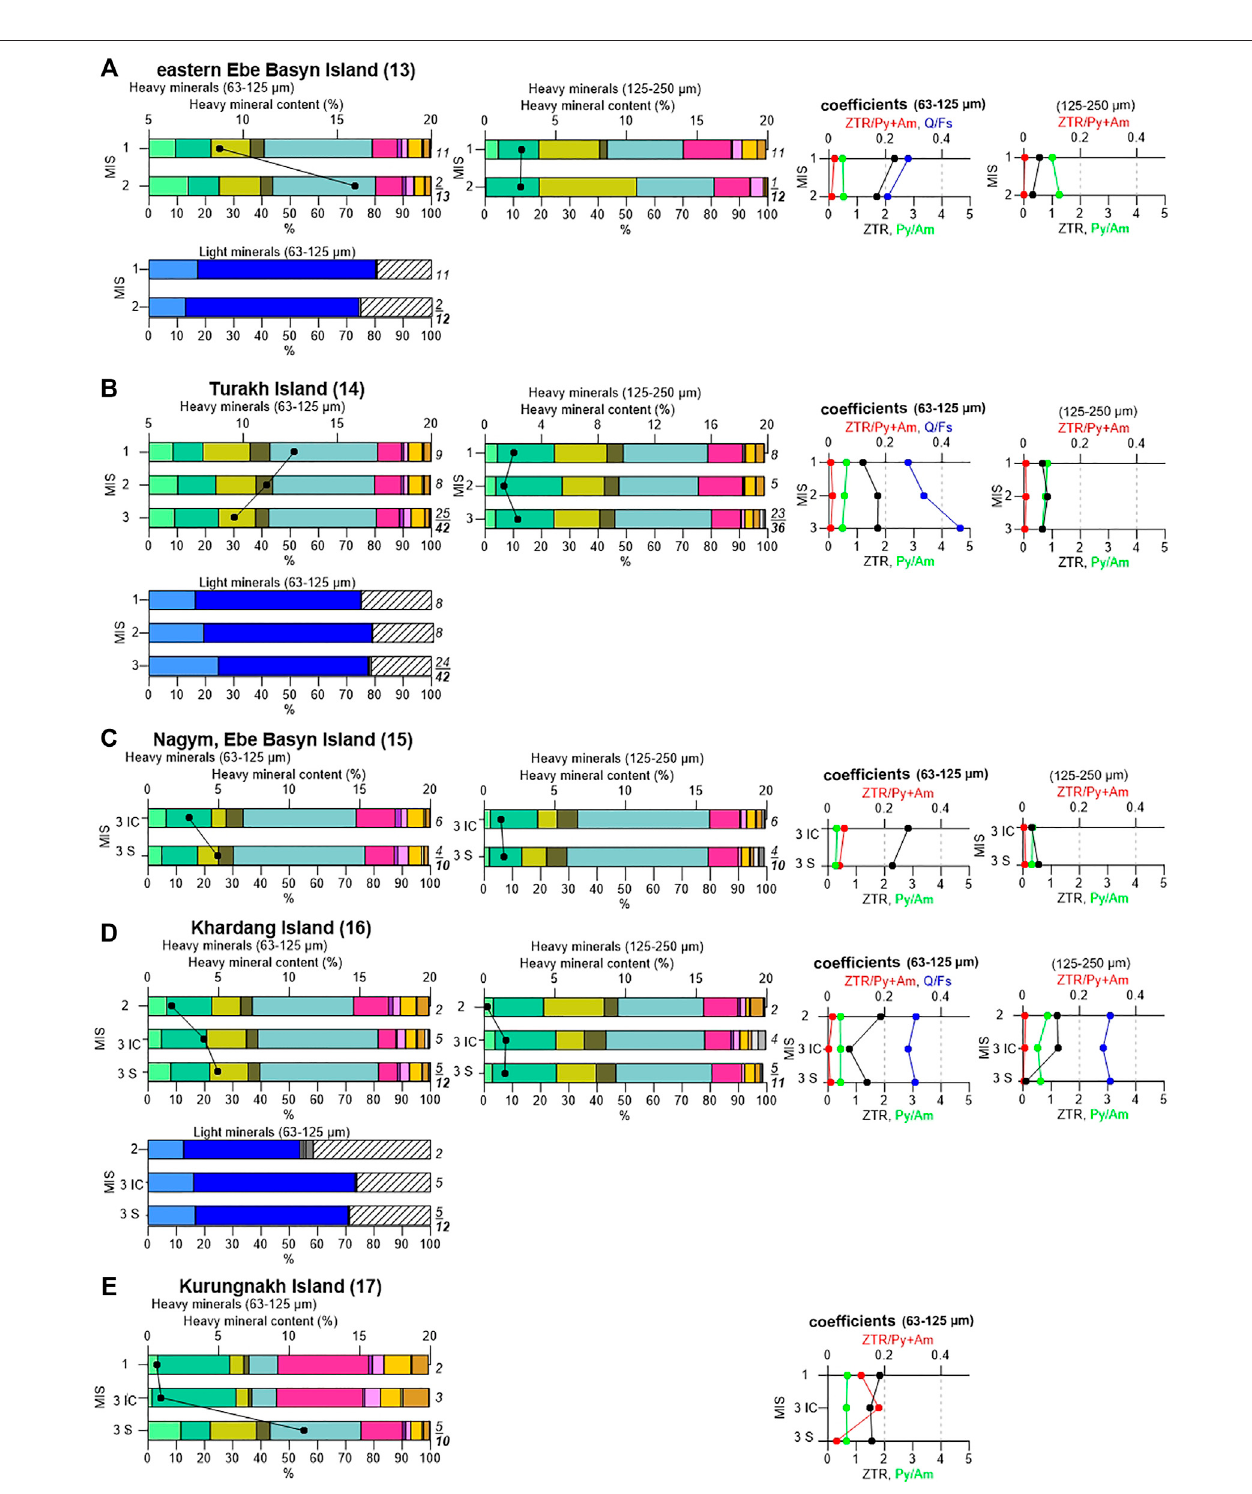
FIGURE 5 | Heavy and light mineral associations of the fi ne and coarse fractions, the heavy mineral contents, and the corresponding mineral coef fi cients from the Lena Delta sites on (A) eastern Ebe Basyn Island (13), (B) Turakh Island (14), (C) Nagym, southern Ebe BasynIsland (15), (D) Khardang Island (16), and (E) Kurungnakh Island (17). The number of samples is in italics to the left of each diagram (Note the mineral coef fi cients have smaller scales than in previous fi gures). For the legend, see Figure 2 .